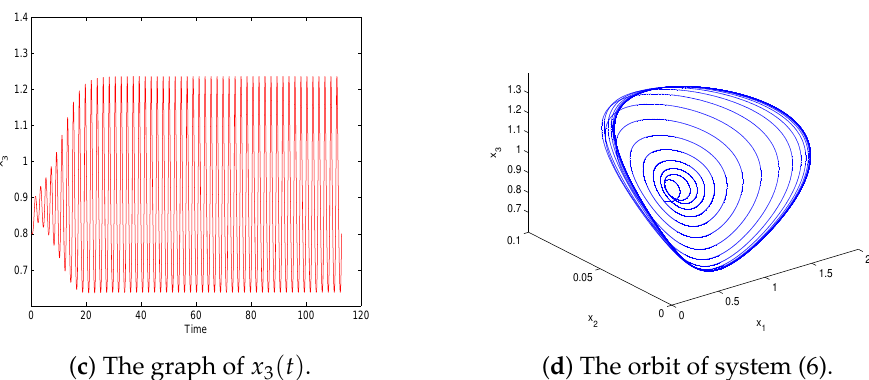
( d ) The orbit of system (6). Figure 3. Behavior of system (6) with τ = 0.45. The positive equilibrium E is unstable. Furthermore, a periodic solution bifurcates from the positive equilibrium and is orbitally asymptotically stable.